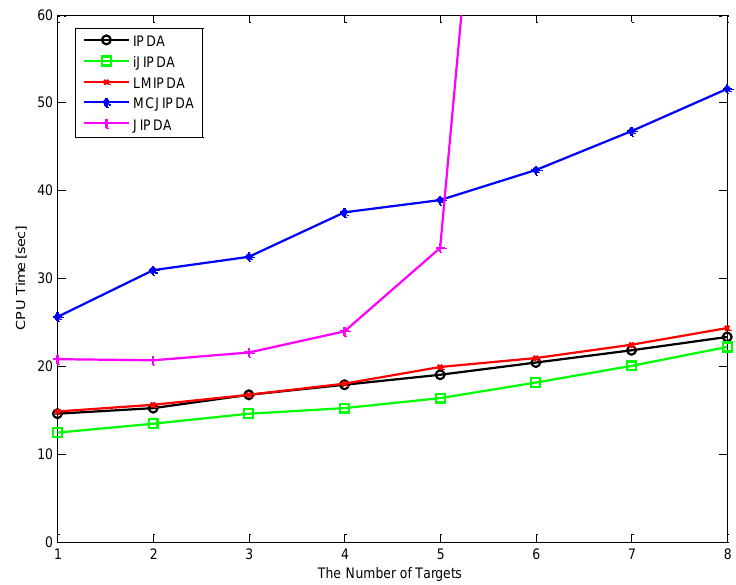
Figure 9. Computational costs of algorithms vary with the number of targets.